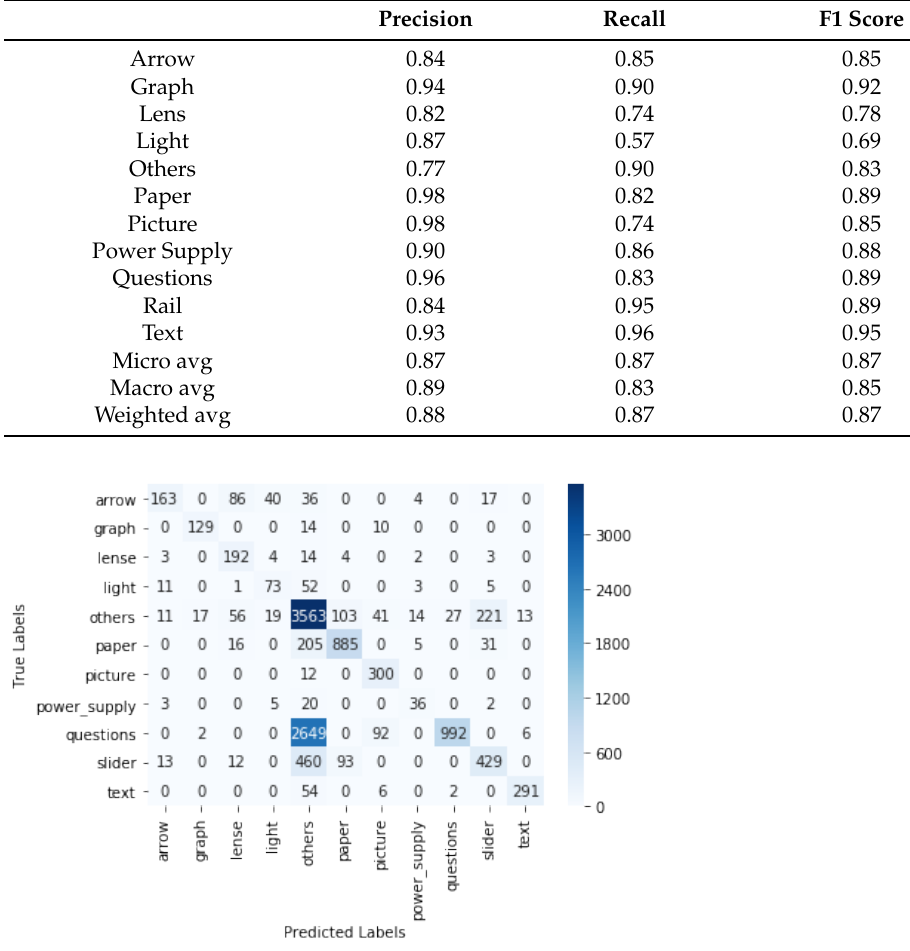
Table 2. Confusion Report for YOLO v4 with interpolation.